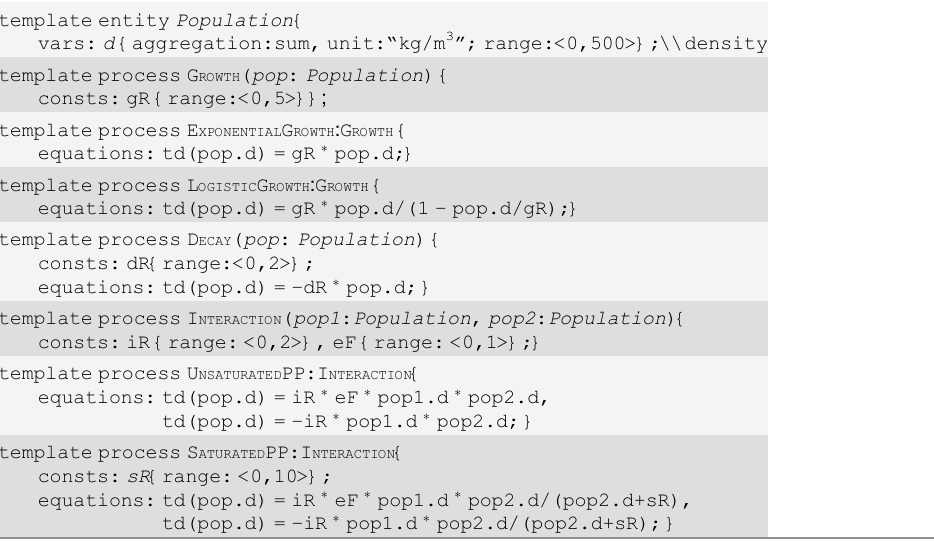
Table 1. Library of domain knowledge for modeling Predator-Prey dynamics. template entity Population { vars: d {aggregation:sum, unit: “ kg/m 3 ” ; range:<0,500>};\\density template process G ROWTH ( pop : Population ) { consts: gR {range:<0,5>}} ; template process E XPONENTIAL G ROWTH : G ROWTH { equations: td(pop.d) = gR (cid:1)